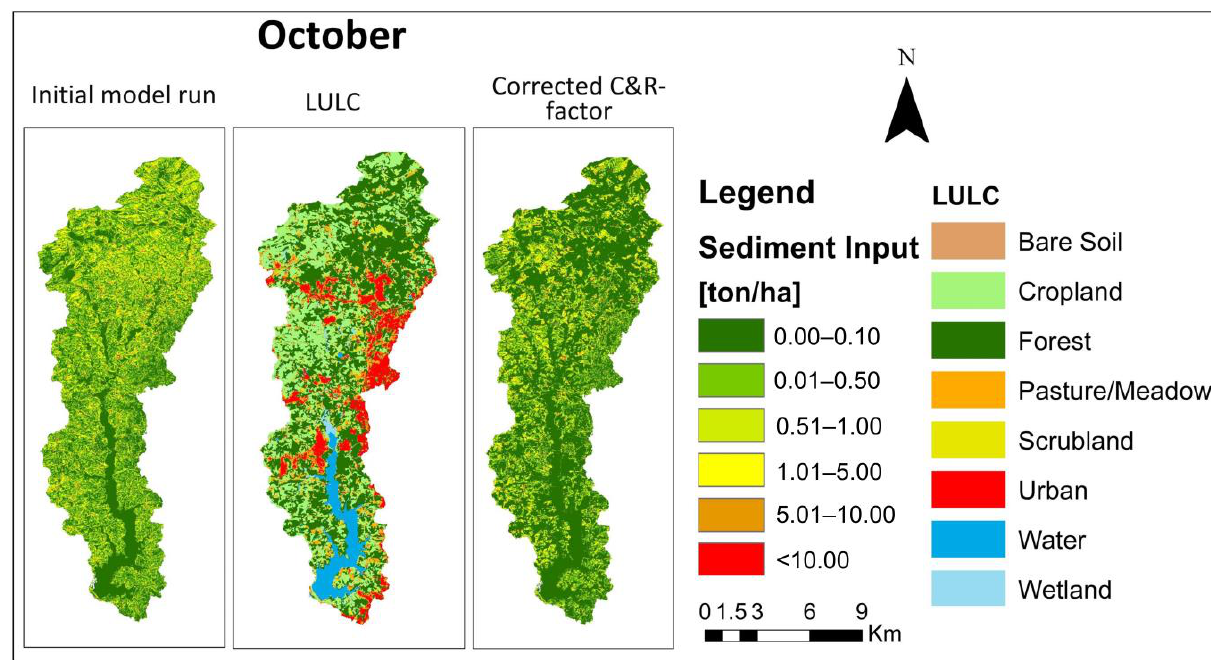
Figure 16. Monthly distribution of sediment input from the initial model run.